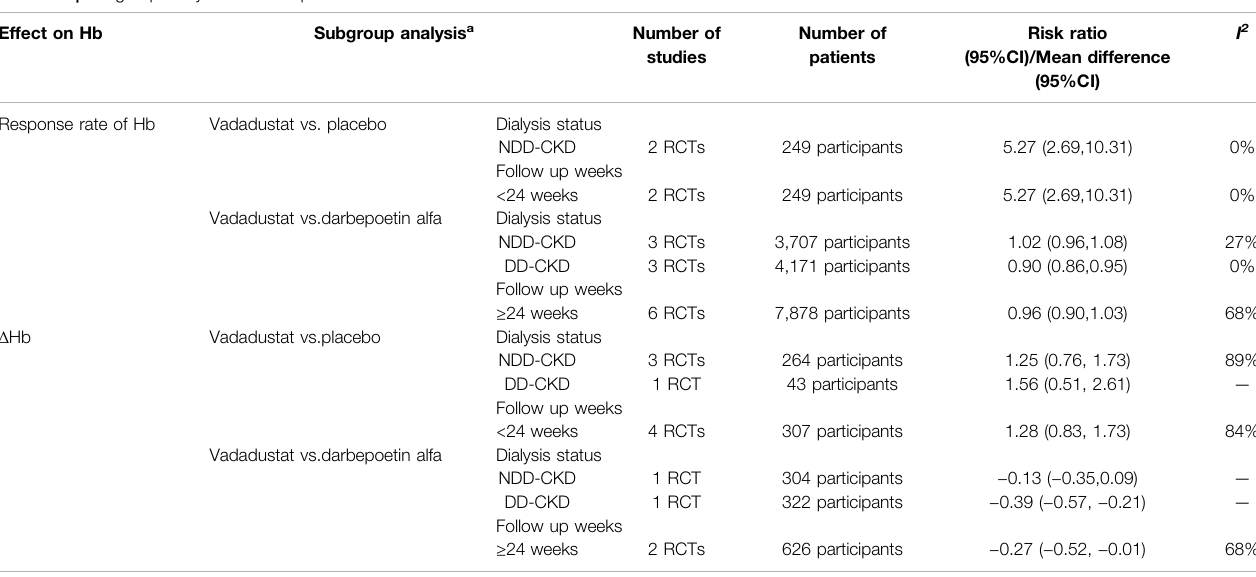
TABLE 2 | Subgroup analysis of the response rate of Hb and Δ